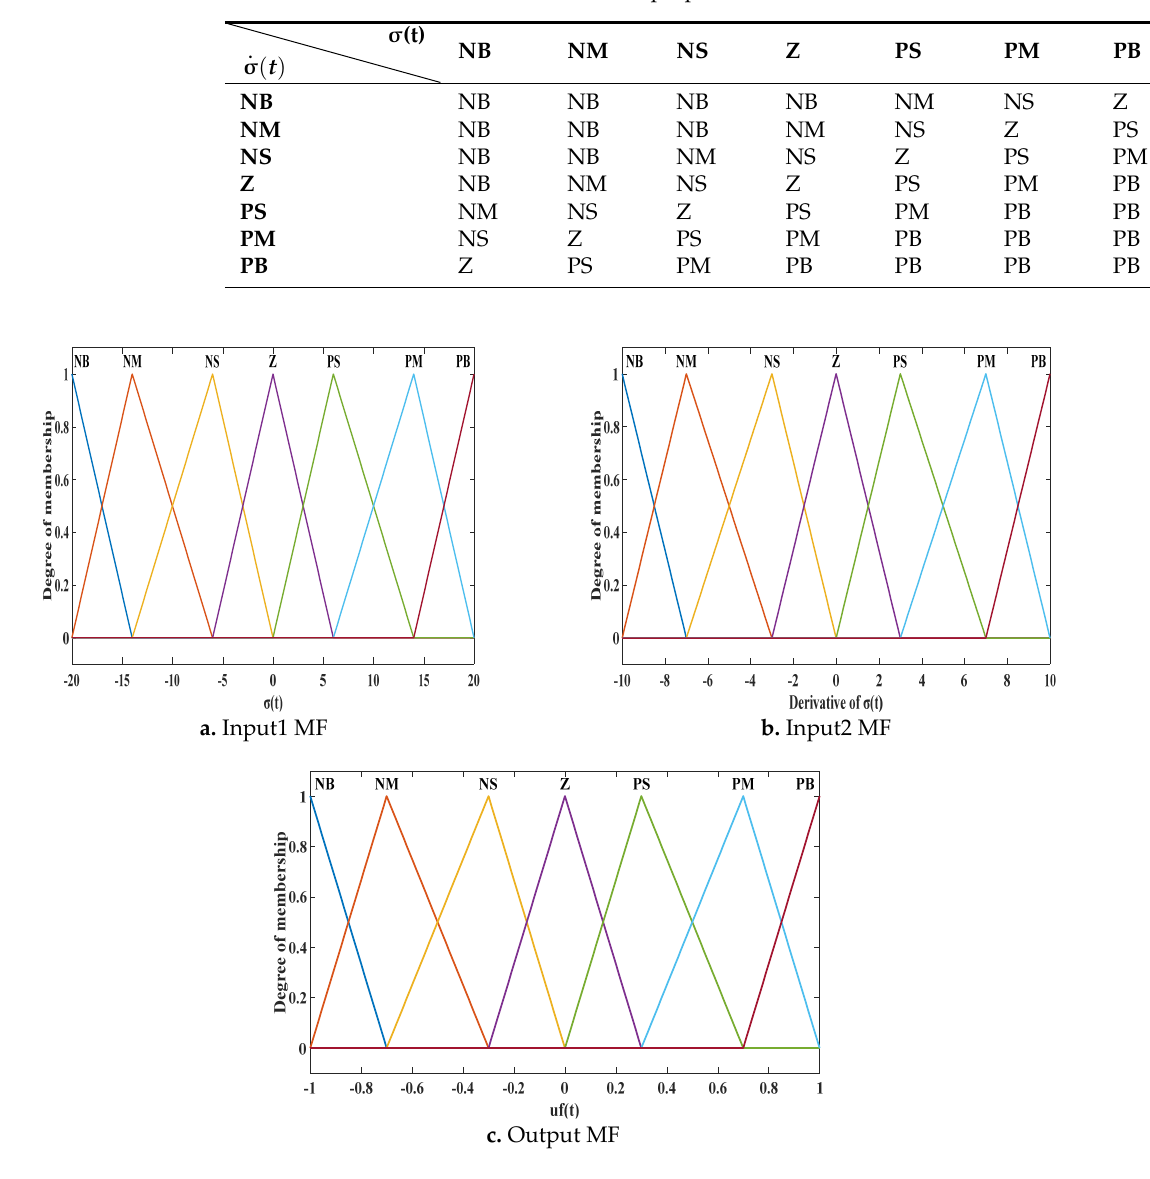
Figure 5. Fuzzy − SFOSMC Parameters.